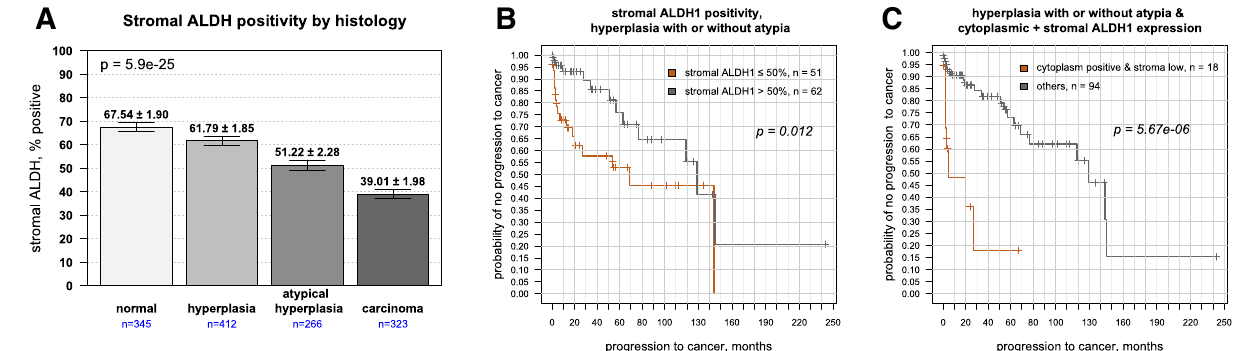
Figure 7. Stromal ALDH1 expression in premalignant lesions predict future tumor development. ( A ) Stromal ALDH1 expression showed a step-wise decrease from normal endometrium to endometrial hyperplasia to atypical hyperplasia to endometrial cancer (Spearman rho = − 0.28, p = 5.9e−25). ( B ) Stromal ALDH1 expression reduced the likelihood of patients to develop cancer. Kaplan–Meier survival plot showing higher stromal ALDH1 expression (> 50% of cells) versus lower expression in hyperplastic lesions with or without atypia: difference in median time to cancer diagnosis 129 months vs 69 months, HR = 0.39, p = 0.012. E) Patients with ALDH1 positivity in the epithelium and low immunostaining in stroma (< 50%) also showed shorter times to cancer diagnosis compared to others (median time interval 6 months vs 129 months, p =